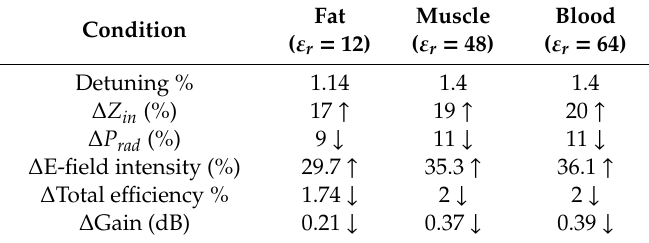
Figure 17. Efficiency and gain of e-textile antenna for various phantom properties. From an ideal antenna perspective, the efficiency is very low, which is due to the low conductivity and thickness of the developed material; however, through observation on the trend, it is clear that higher loss medium will result in lower gain. Table 3. Changes in the antenna’s performance variables when located on a human phantom in comparison to a free space condition. The significance of each parameter is explained in the paragraph. ( r = 12) ( r = 48)